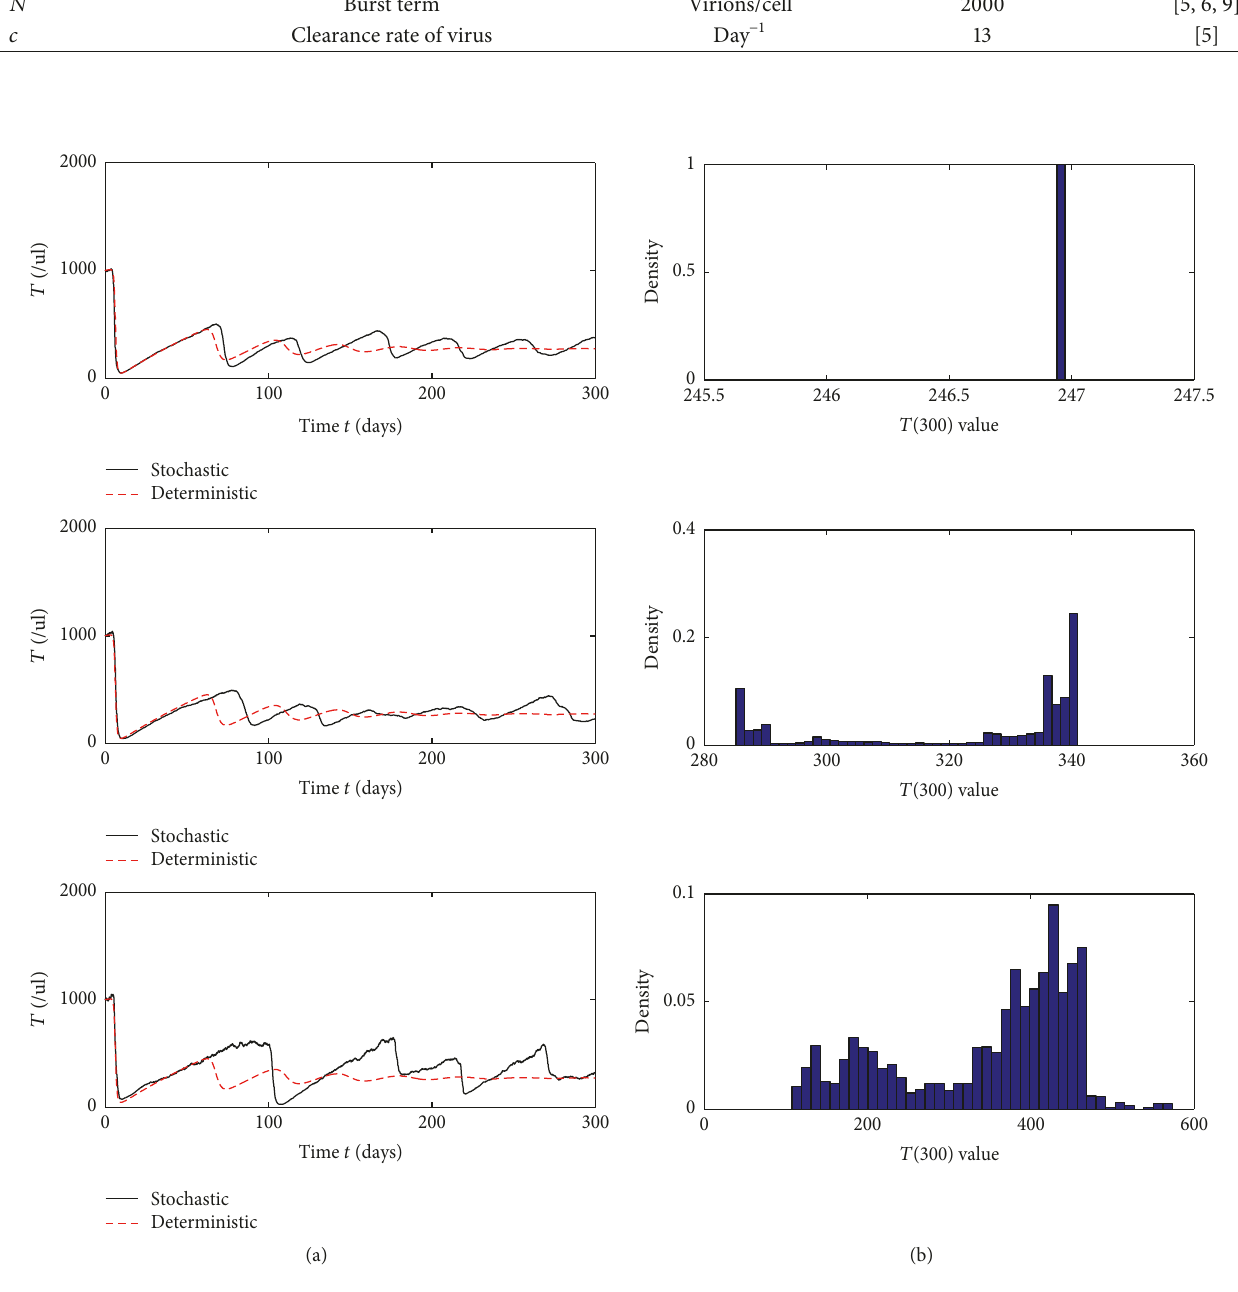
Figure 1: (a) Simulations of healthy target cells for the stochastic model (3) and its corresponding deterministic model (1) with three different sets of white noise. (b) Probability density of the values of the path 𝑇(𝑡) at 𝑡 = 300 for system (3) based on 10000 simulation runs. For parameters see Table 1 with (𝜎 1 , 𝜎 2 ,𝜎 3 ) equal to (0.008, 0.3, 1) , (0.01, 0.4, 1.2) , and (0.02, 0.8, 1.5) ,